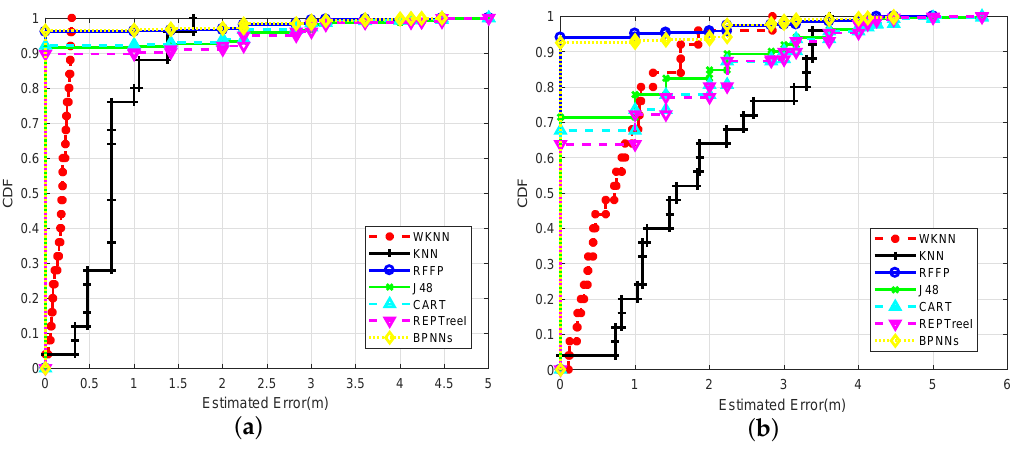
Figure 8. ( a ) CDFs of localization errors with different algorithms in the microwave anechoic chamber. ( b ) CDF of localization errors with different algorithms in the office